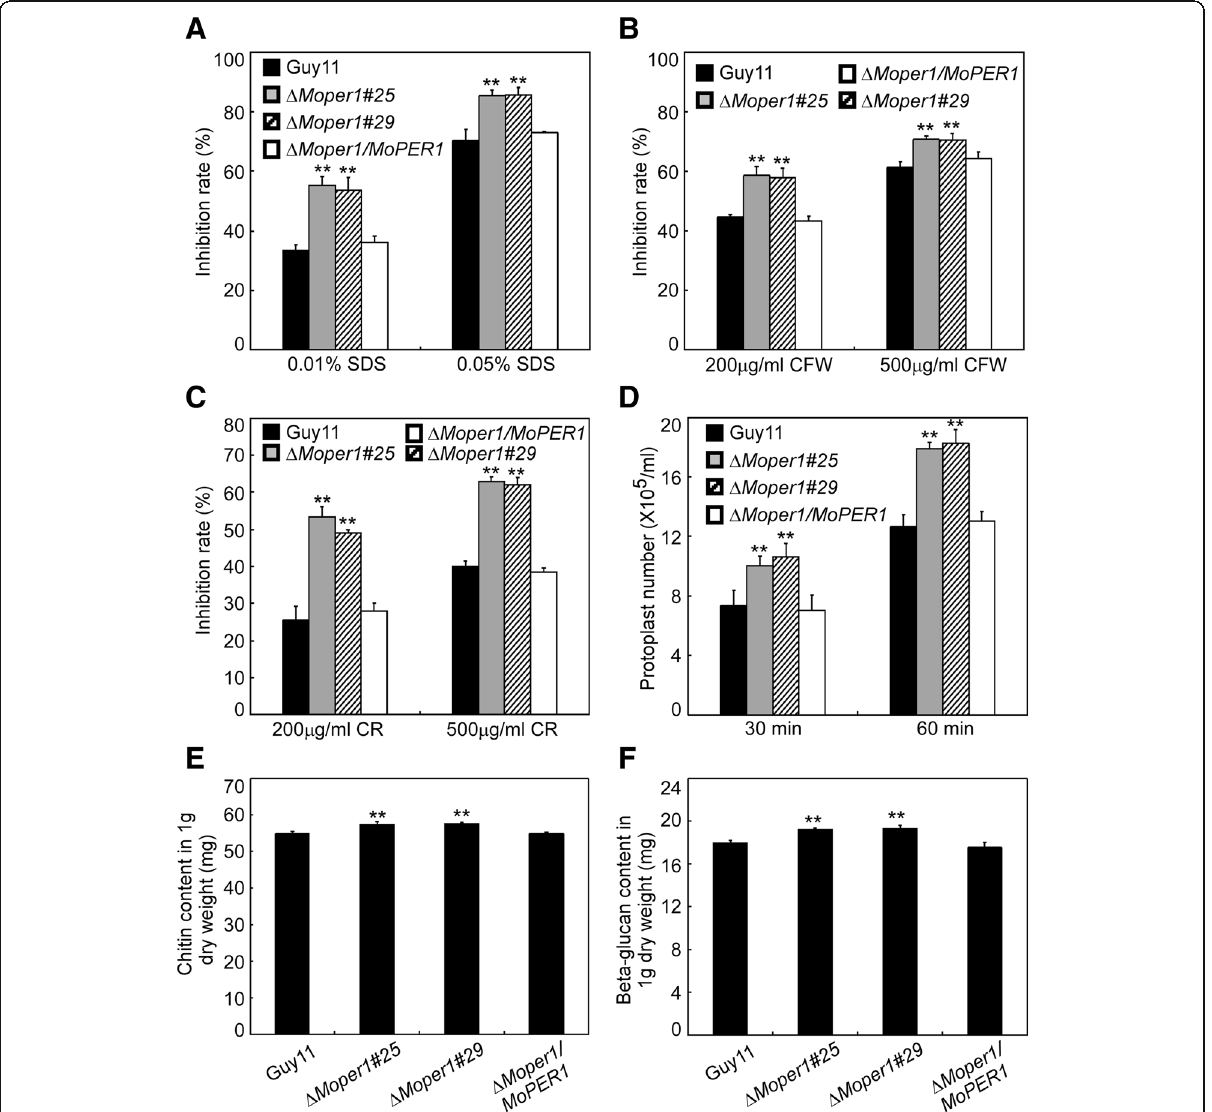
Fig. 3 The MoPER1 deletion mutant had defects in cell wall integrity. a - c The wild type strain Guy11 and the Δ Moper1 strain were inoculated on CM medium with or without SDS (0.01% and 0.05% w / v ), CFW (200 and 500 μ g/ml) and CR (200 and 500 μ g/ml), and cultured at 28 °C for 7 days. The growth inhibition rate is estimated relative to the growth rate of each untreated control [Inhibition rate = (the diameter of untreated strain – the diameter of treated strain)/(the diameter of untreated strain × 100%)]. Three repeats were performed and similar results obtained. d Protoplast released under the treatment of cell-wall-degrading enzymes, The released protoplast was quantified at 30 min intervals. e and f Quantification of the chitin and β -glucan content of the mutant by